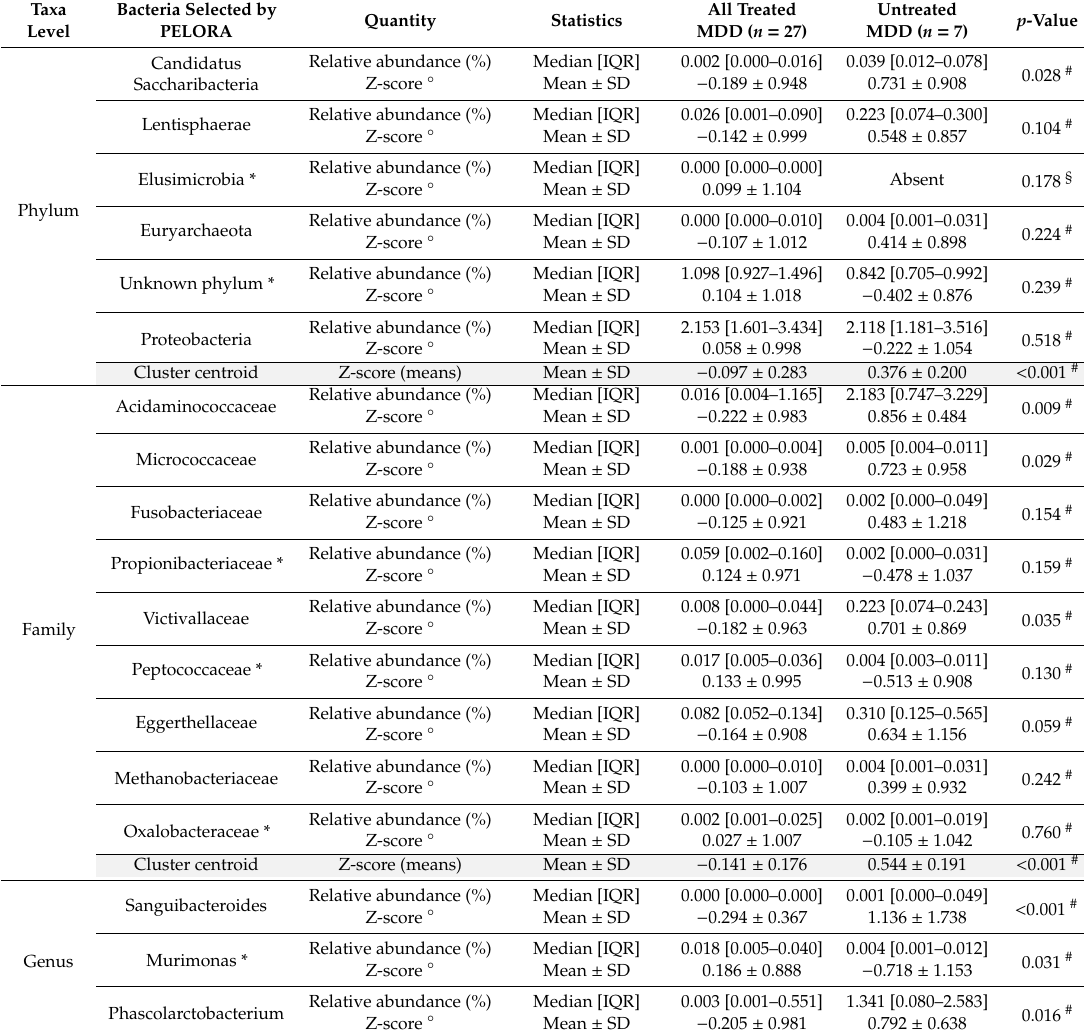
Table 3. Results from the penalized logistic regression analysis (PELORA) algorithm which identifies pathways of bacterial populations that best discriminate all treated patients with major depressive disorder from untreated ones at sample